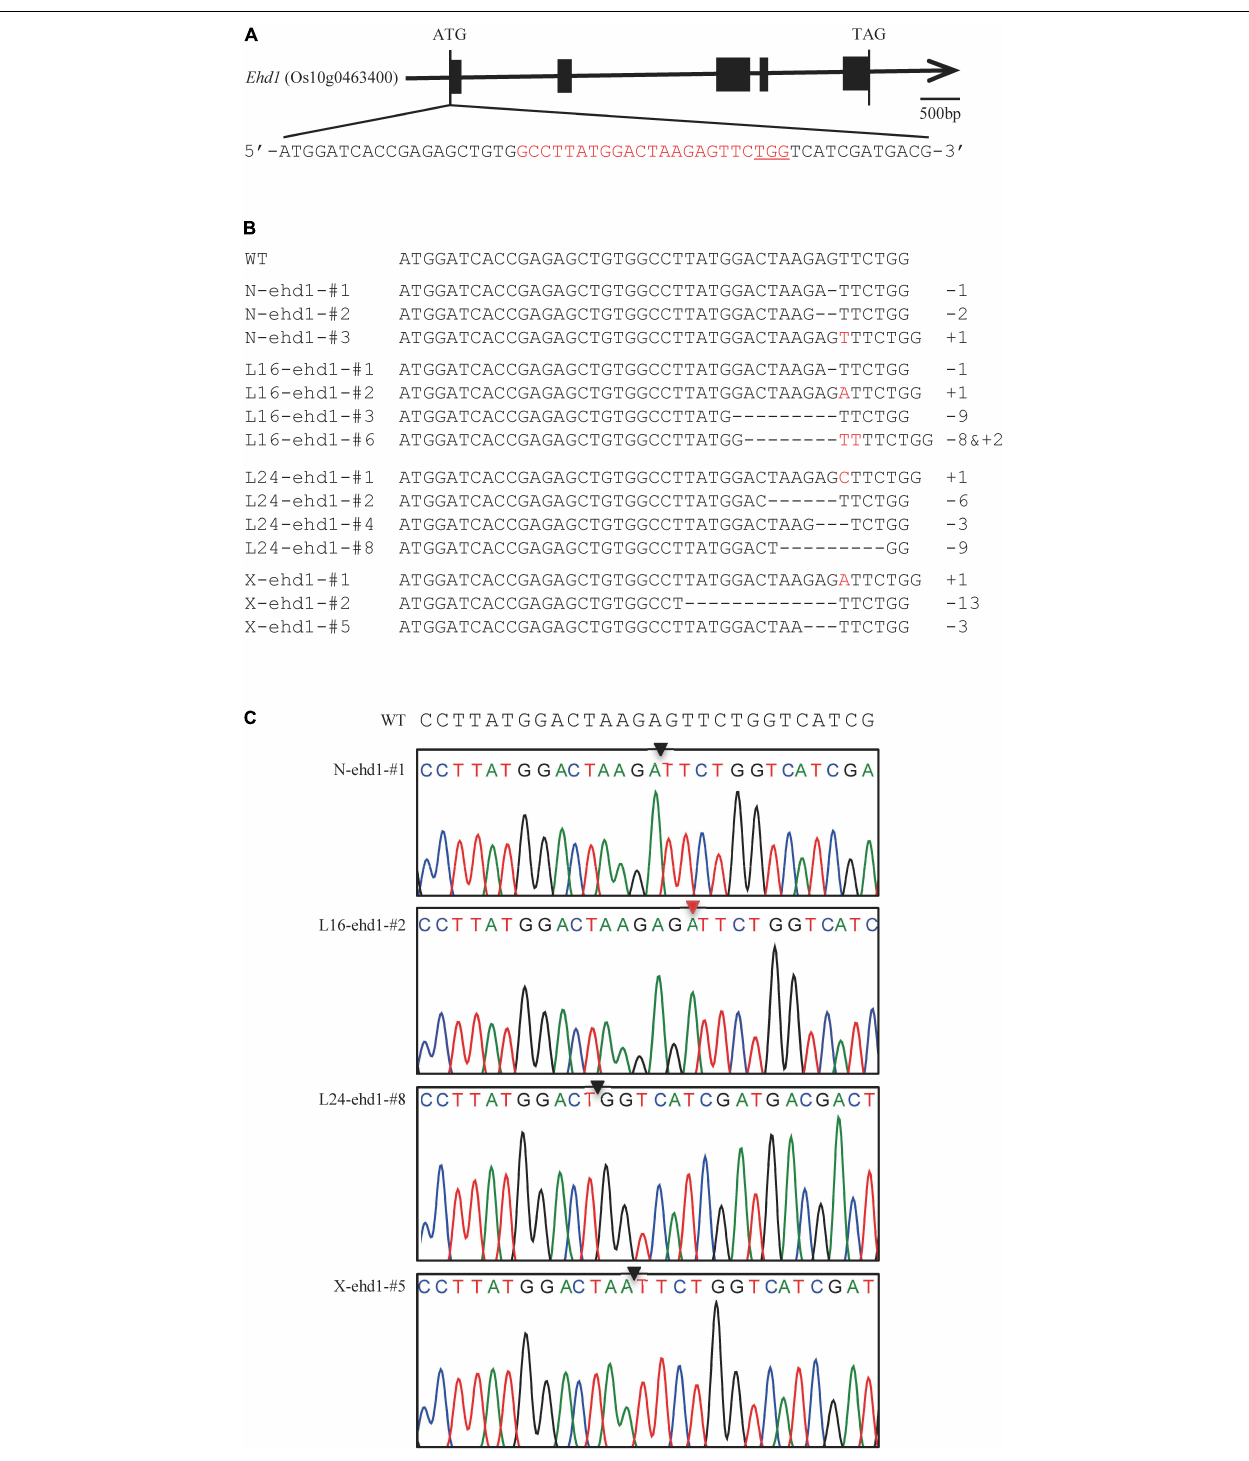
Frontiers in Plant Science |